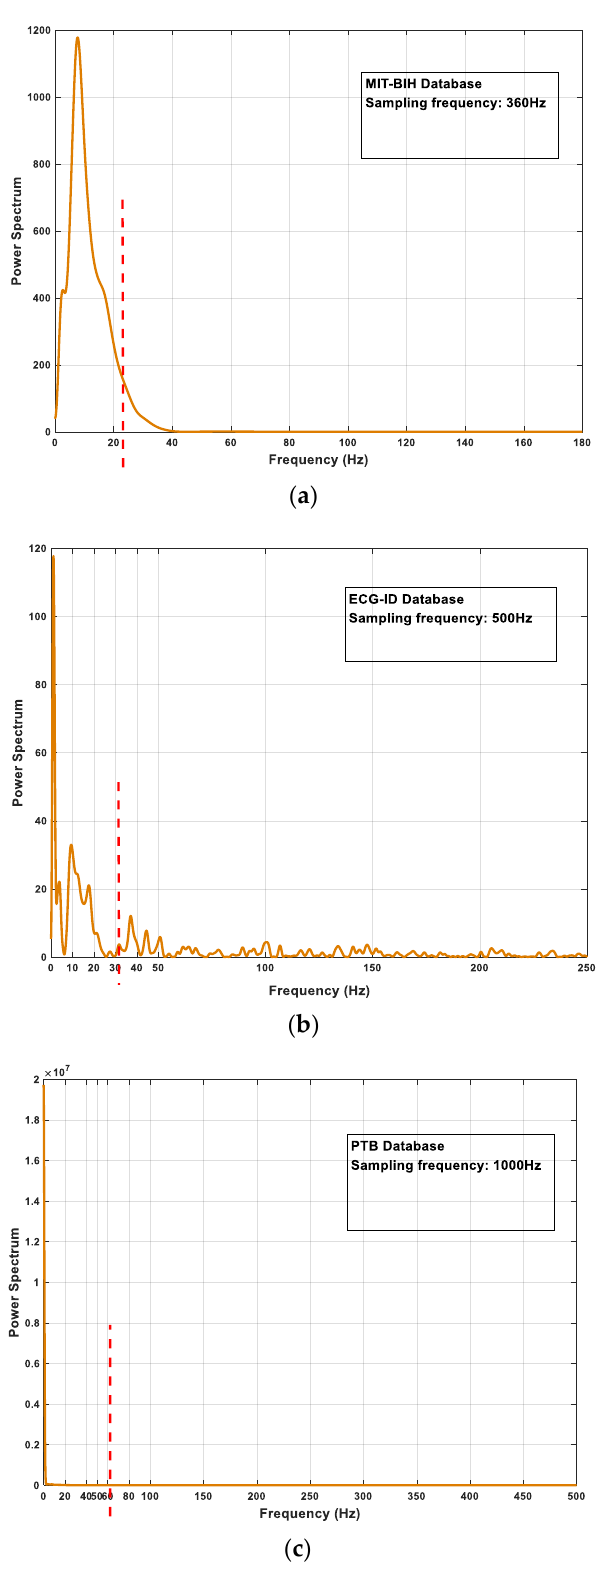
Figure 4. The power spectrum curves of ECG signals in three databases. ( a ) MIT-BIH database; ( b ) ECG-ID database; ( c ) PTB database.